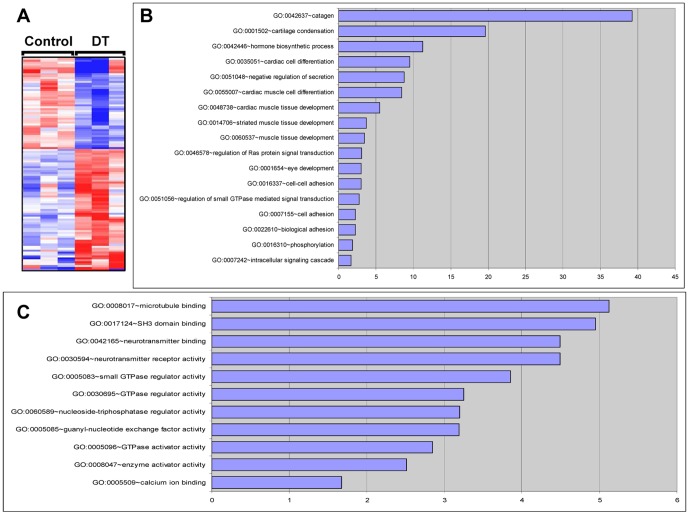
Transcriptome analysis of mycHIF3α expressing lungs.Treescape showing that the transcriptome of the lungs of the mycHIF3α expressing animals are significantly different from that of the control lungs (A). The red color indicates the upregulated genes and the blue color indicates downregulated genes. The expression of the genes presented in the treescape is at least 1.5 fold changed with a false discovery rate (FDR) of 10%. The top 10 biological processes (B) and molecular functions (C) of the differentially expressed genes are shown.